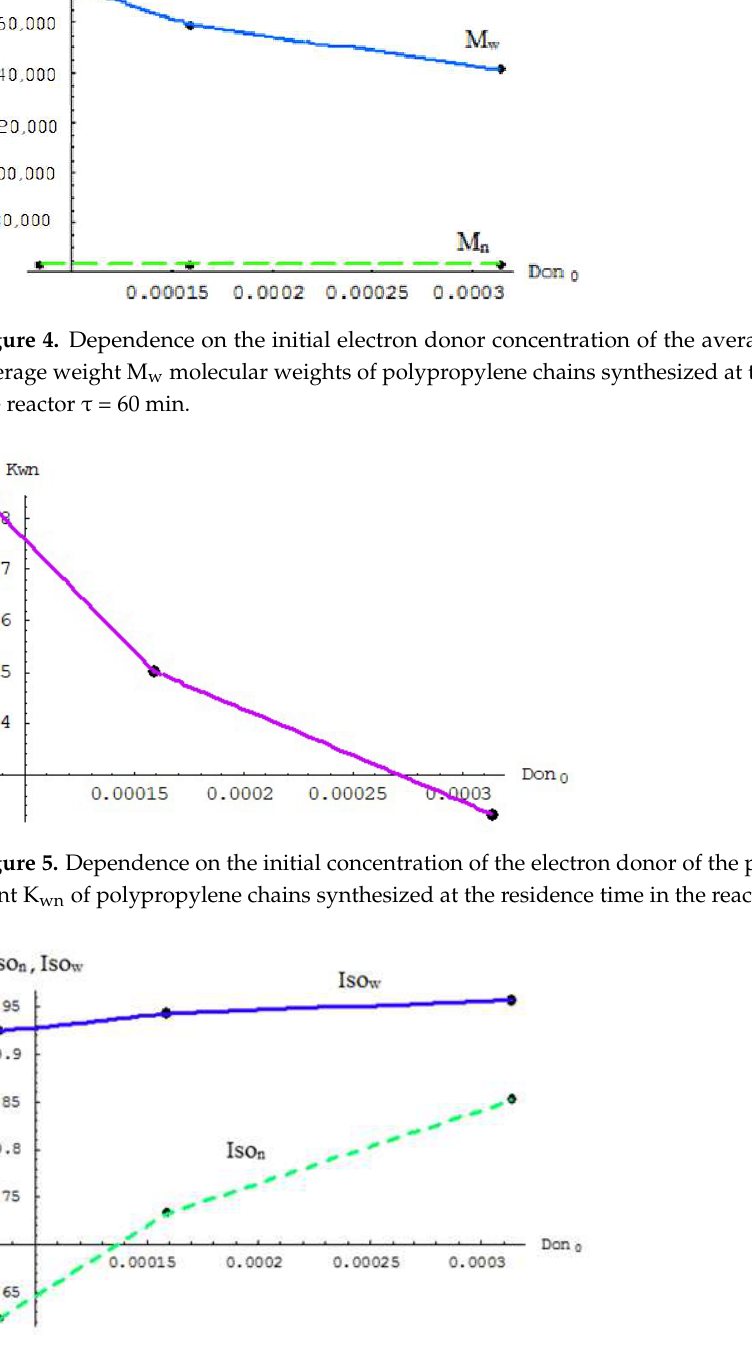
Figure 6. Dependence on the initial electron donor concentration of molar Iso n and mass (or weight) Iso w fractions of purely isotactic chains synthesized at the residence time in the reactor τ = 60 min.